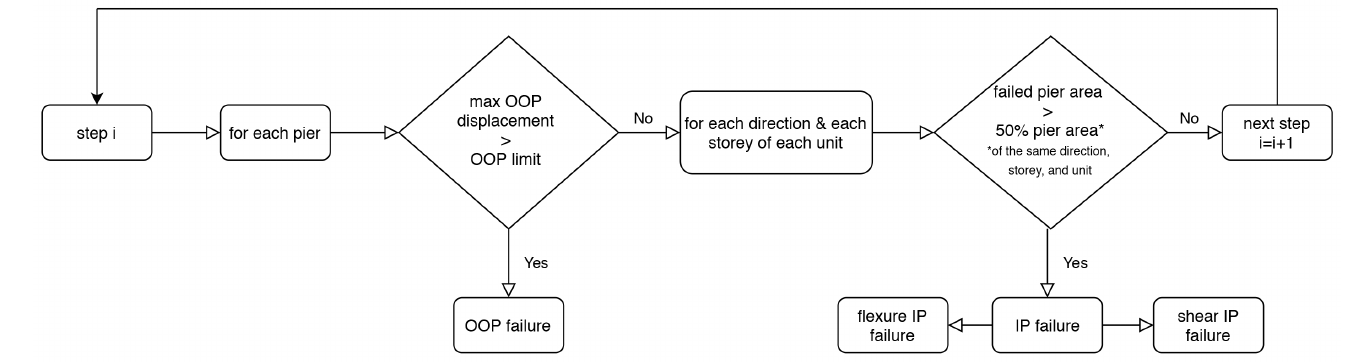
Figure 7. Building failure criterion chart describing the procedure to classify the building model as collapsed. OOP, out-of-plane failure; IP, in-plane failure.